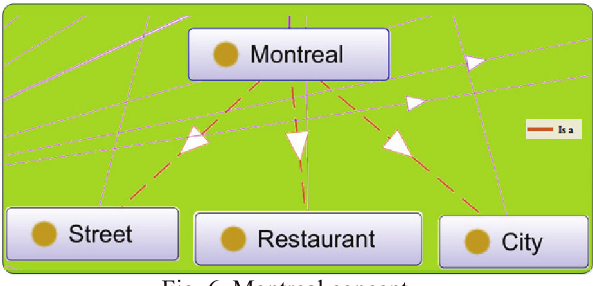
Fig. 6. Montreal concept